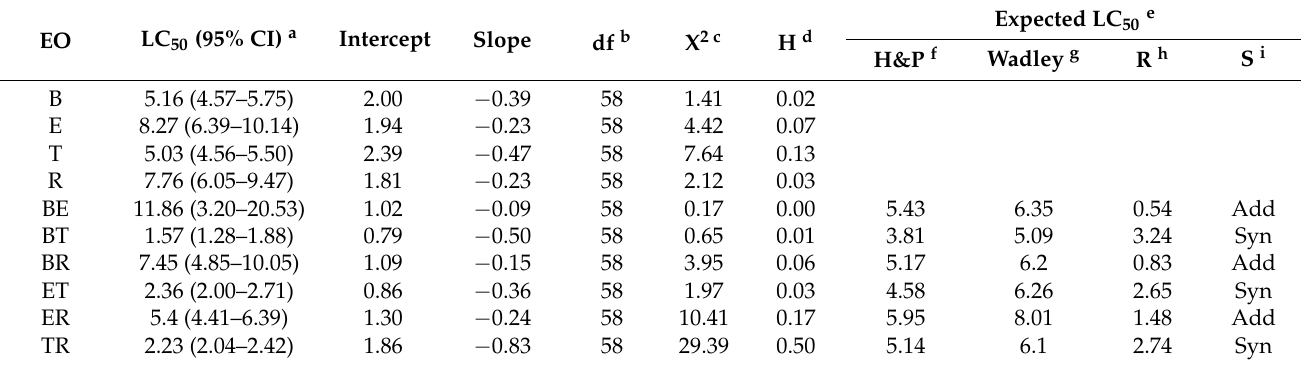
Table 4. Synergistic interaction of six binary combinations of four essential oils against aphids M. persicae after 24 h contact